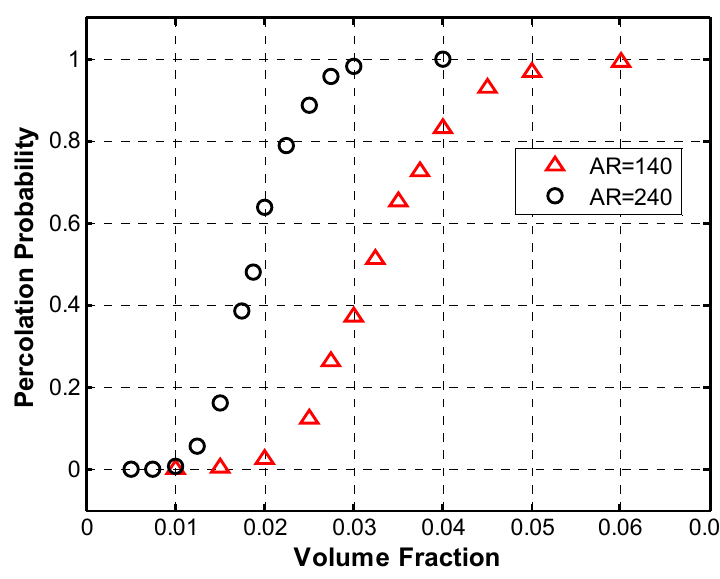
Figure 22. Comparison of percolation probability curves with different aspect ratios, g = 0.3.